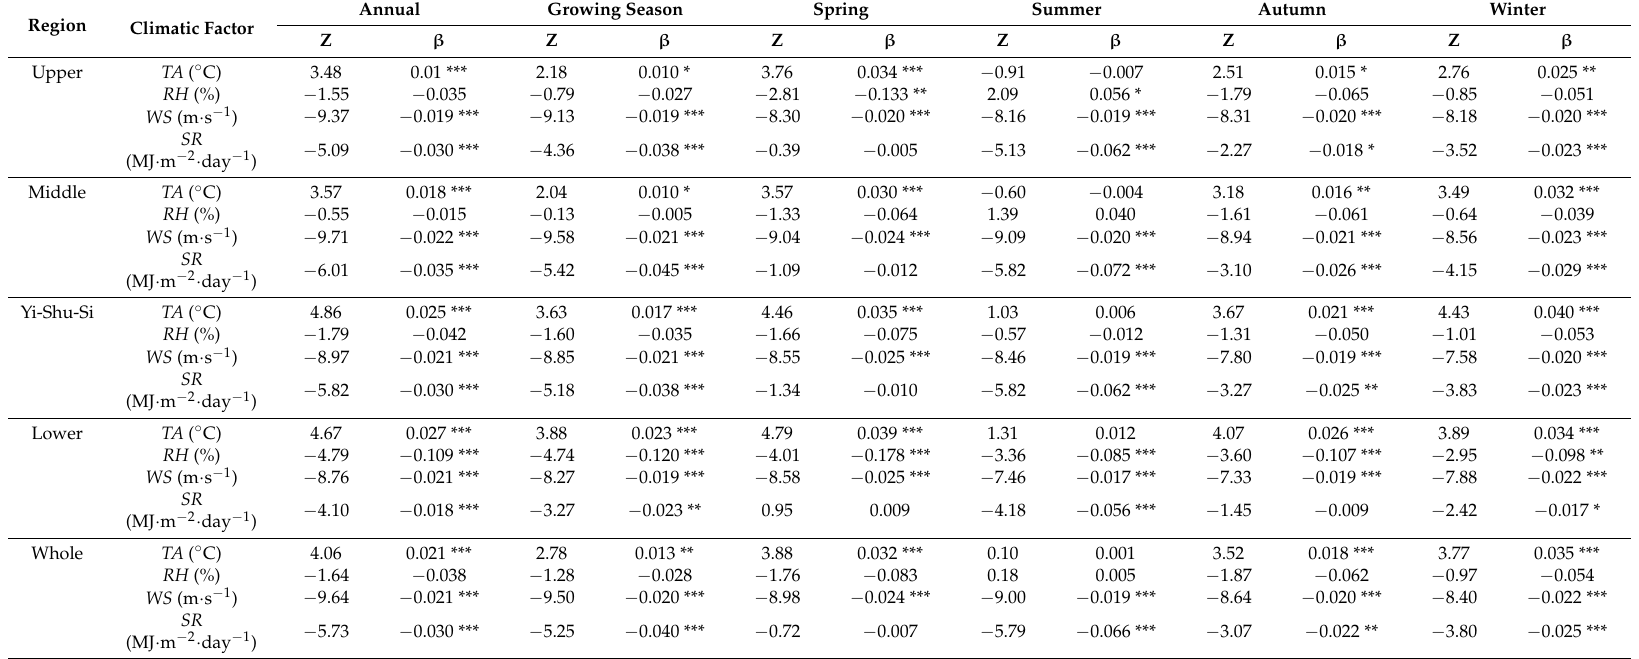
Table 1. Seasonal and annual trend analyses of climatic factors in each region of the HRB during